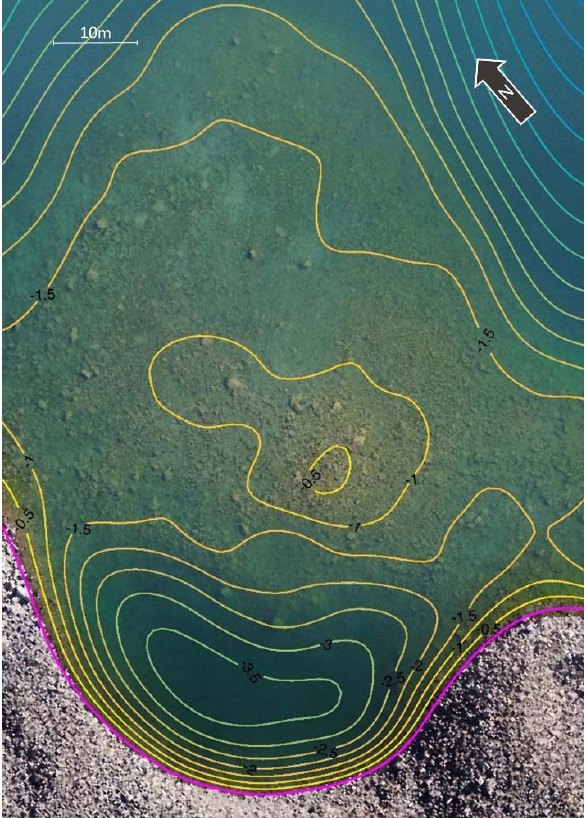
Figure 7: DTM computed via multimedia forward-intersection. The magenta line indicates the shore-line derived from intersection of DEM with water-surface.